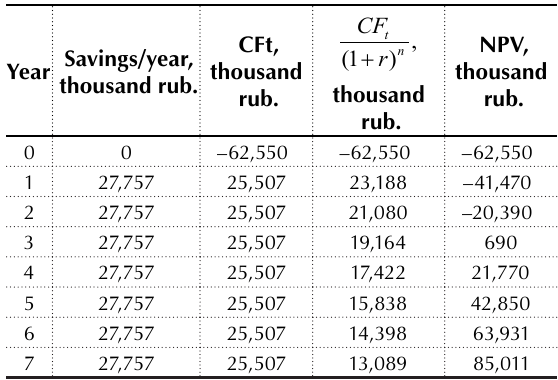
Table 5. Calculation of NPV of the